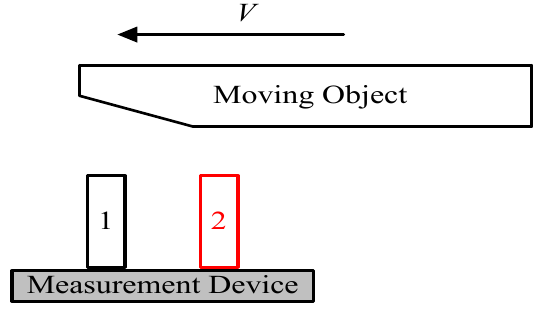
Figure 9. Diagram for a moving object with varying reflecting